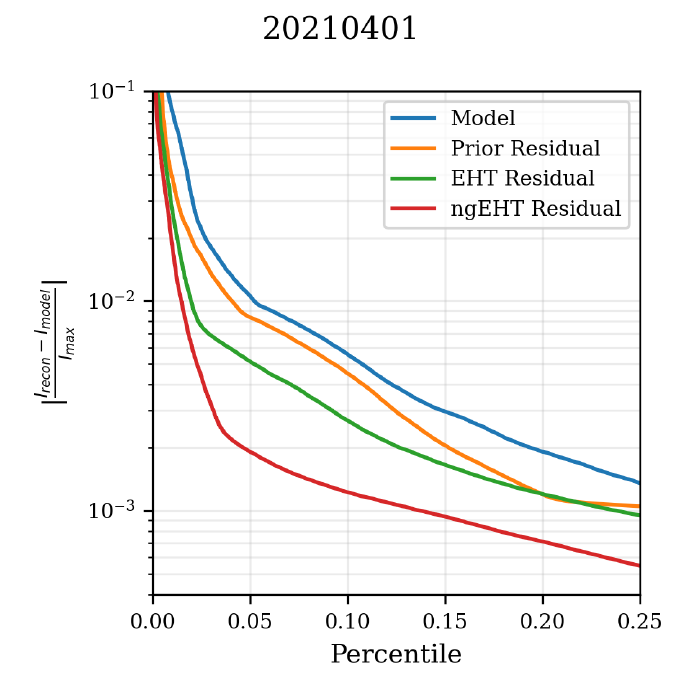
Figure 12. Cumulative distribution of the residual noise of M87’s prior (orange), EHT reconstruction (green), and ngEHT reconstruction (red). The x-axis is the percentile of the residual image intensity. The model (blue) corresponds to a normalized distribution of the model image itself, i.e., I recon = 0 in Equation (1).